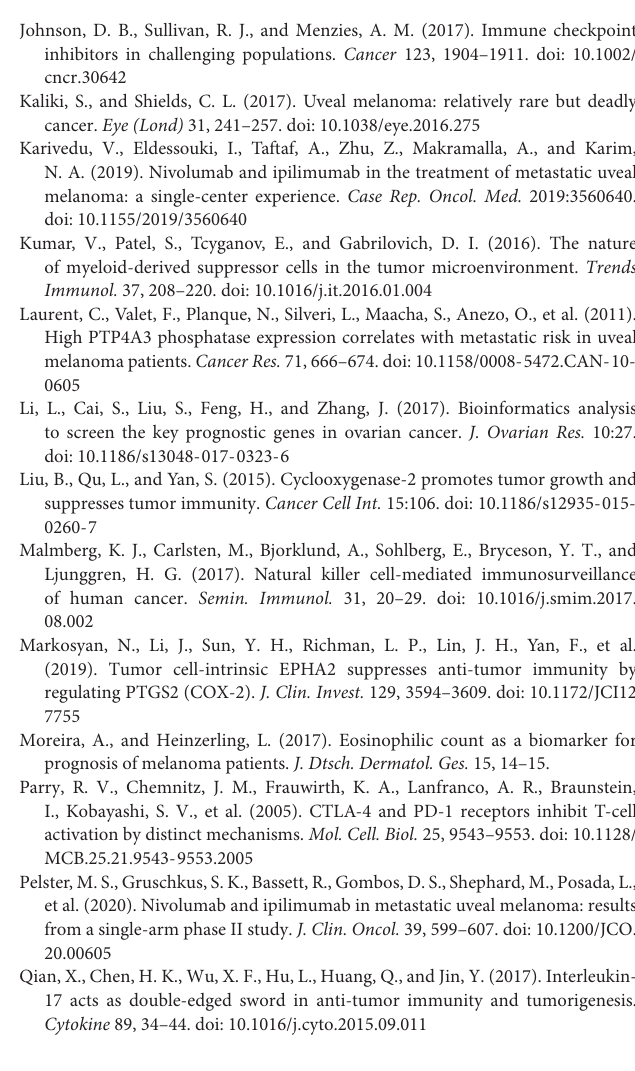
Supplementary Figure 1 | Consensus clustering based on immune gene expression of 80 UVM in TCGA. (A) Flow chart of the study. (B) Clustering matrix for K = 2. (C) CDF curve for k = 2 to k = 6. (D) Delta area for k = 2 to k = 6. (E) GO analysis of genes upregulated in class2. Supplementary Figure 2 | (A) Heatmap of immune function score. (B) Heatmap of immune checkpoint related genes expression. ** P < 0.05. Supplementary Figure 3 | (A) Heatmap of the correlation between immune cells and immune checkpoints. (B) Heatmap of the correlation between immune cells. Supplementary Figure 4 | (A) Survival analysis of the risk score of GSE22138. (B) Survival analysis of the risk score of TCGA-LGG. (C) Survival analysis of the risk score of TCGA-SKCM. (D) Survival analysis of the risk score of